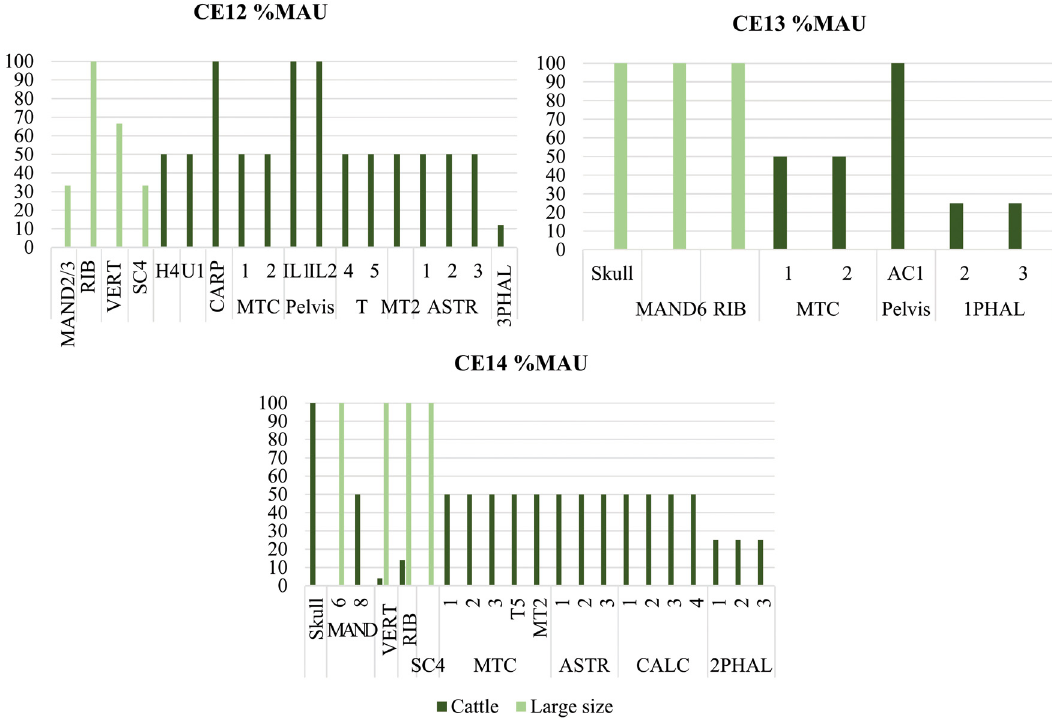
Figure 5: Graphic representation of the %MAU of cattle of all levels with more than 10